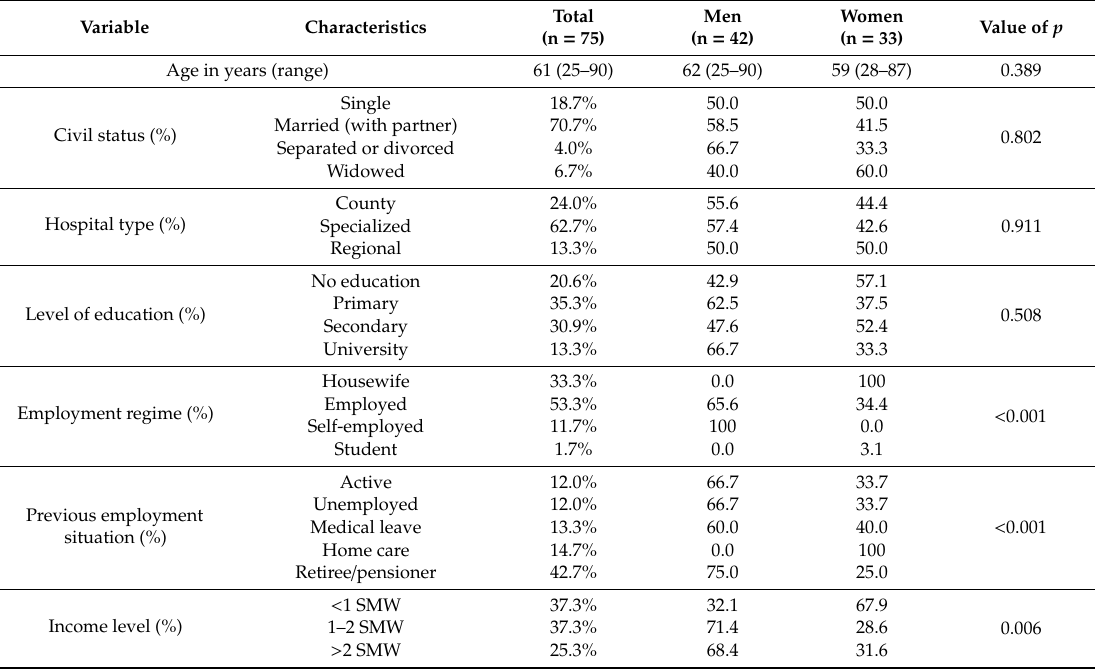
Table 2. Patients sociodemographic characteristics.